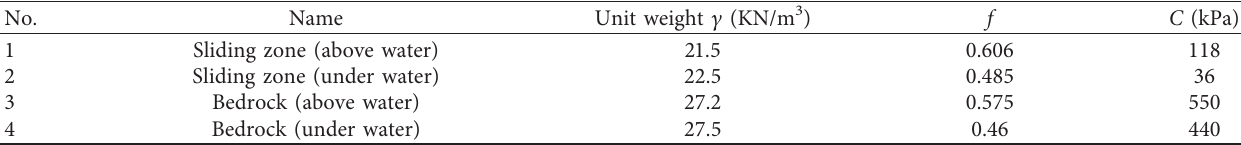
Table 7: Calculation parameters of the landslide.